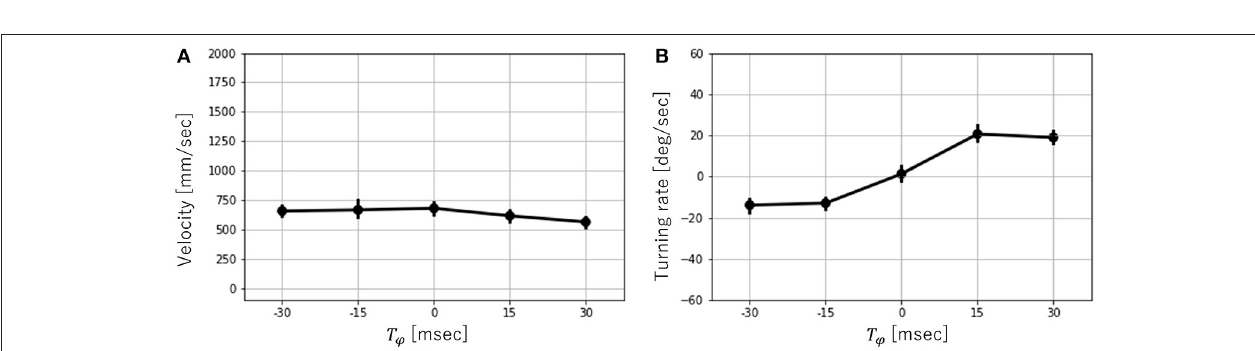
FIGURE 8 | Turning behavior captured by the camera near the ceiling every 1/30 s with T = 450. (A) T φ = 0, (B) T φ = 15.